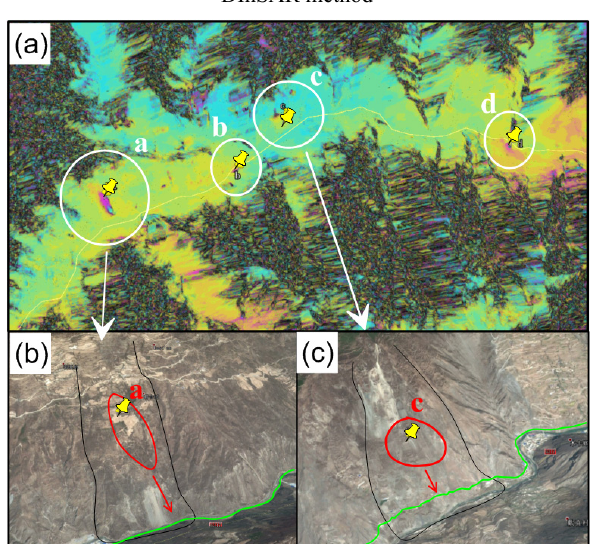
Figure 4. Enlarged (i) area with four potential landslide area. Interferogram(a) and optical images from Google Earth(b)(c) were